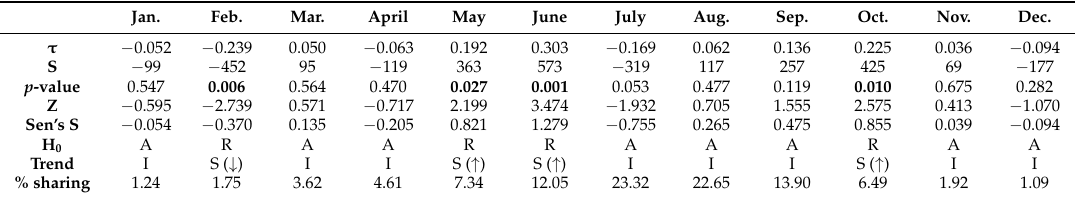
Figure 6. Time series plot for the total annual rainfall for UBNB. The dashed line indicates the Sen’s Slope trend line. Y-axis represents total annual rainfall (mm). Table 3. Summary results of Mann–Kendall trend analysis for monthly-averaged rainfall over the